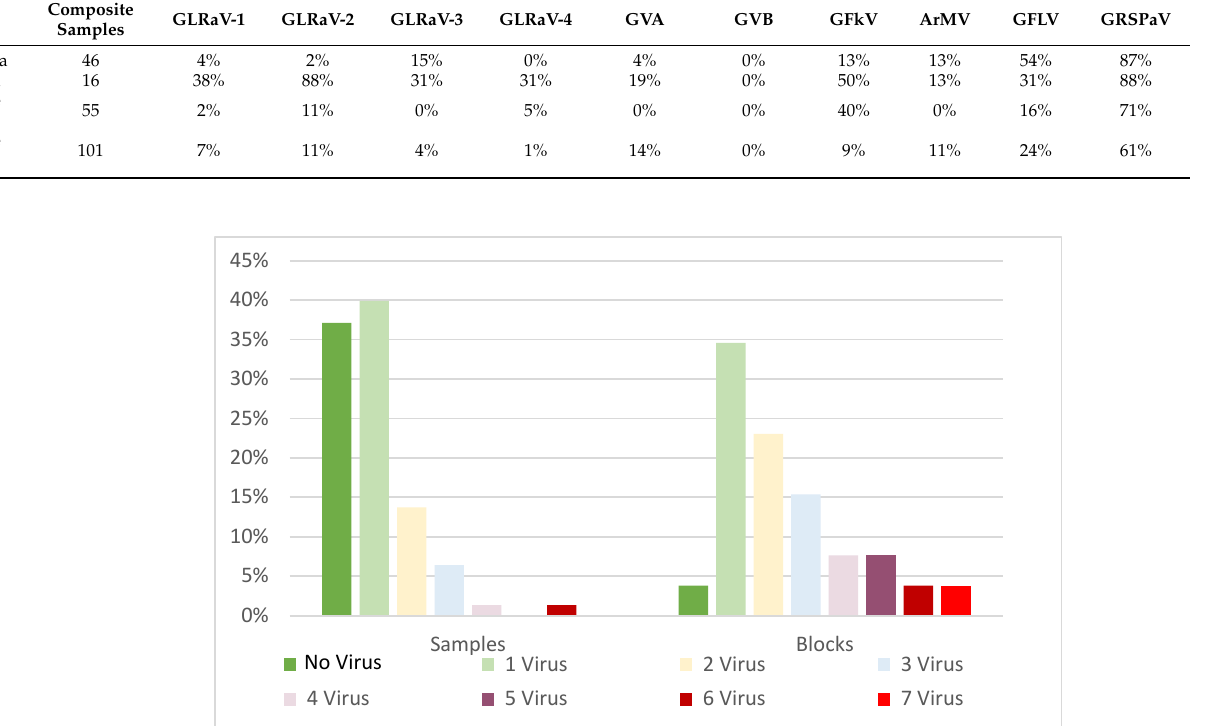
Figure 2. Frequency distribution of virus infections per individual sample and block (excluding GRSPaV).